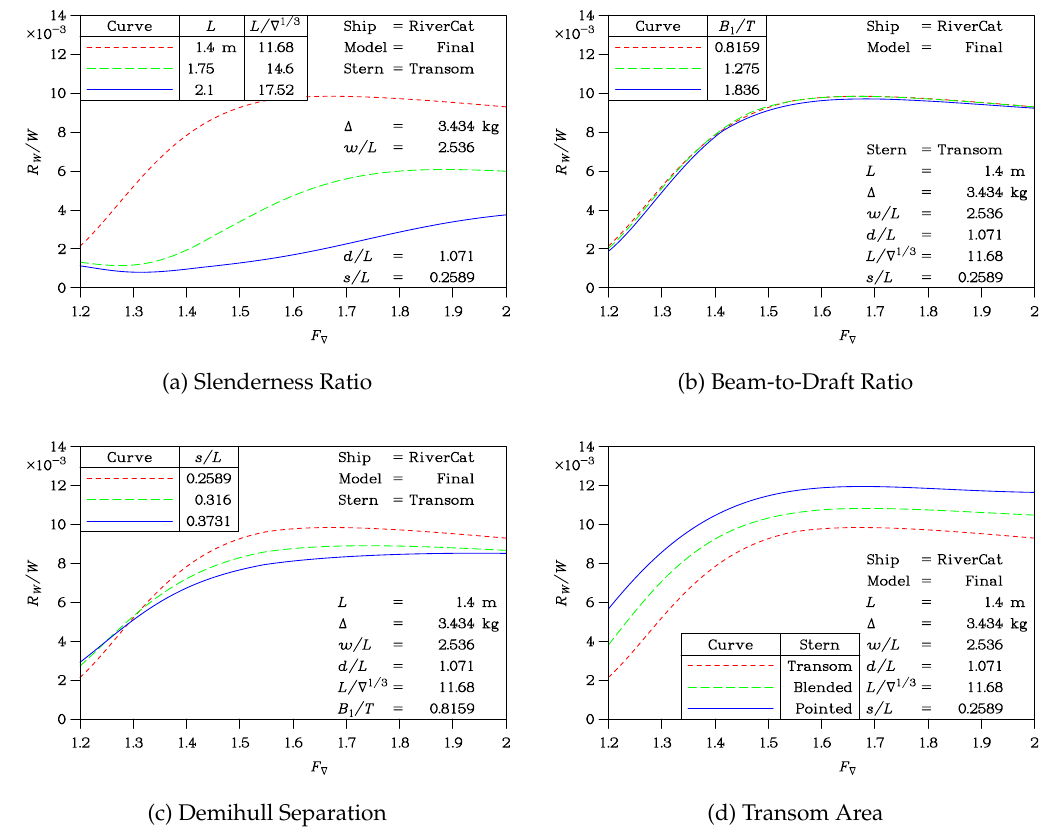
Figure 9. Influence of Affine Transformations on Wave Resistance